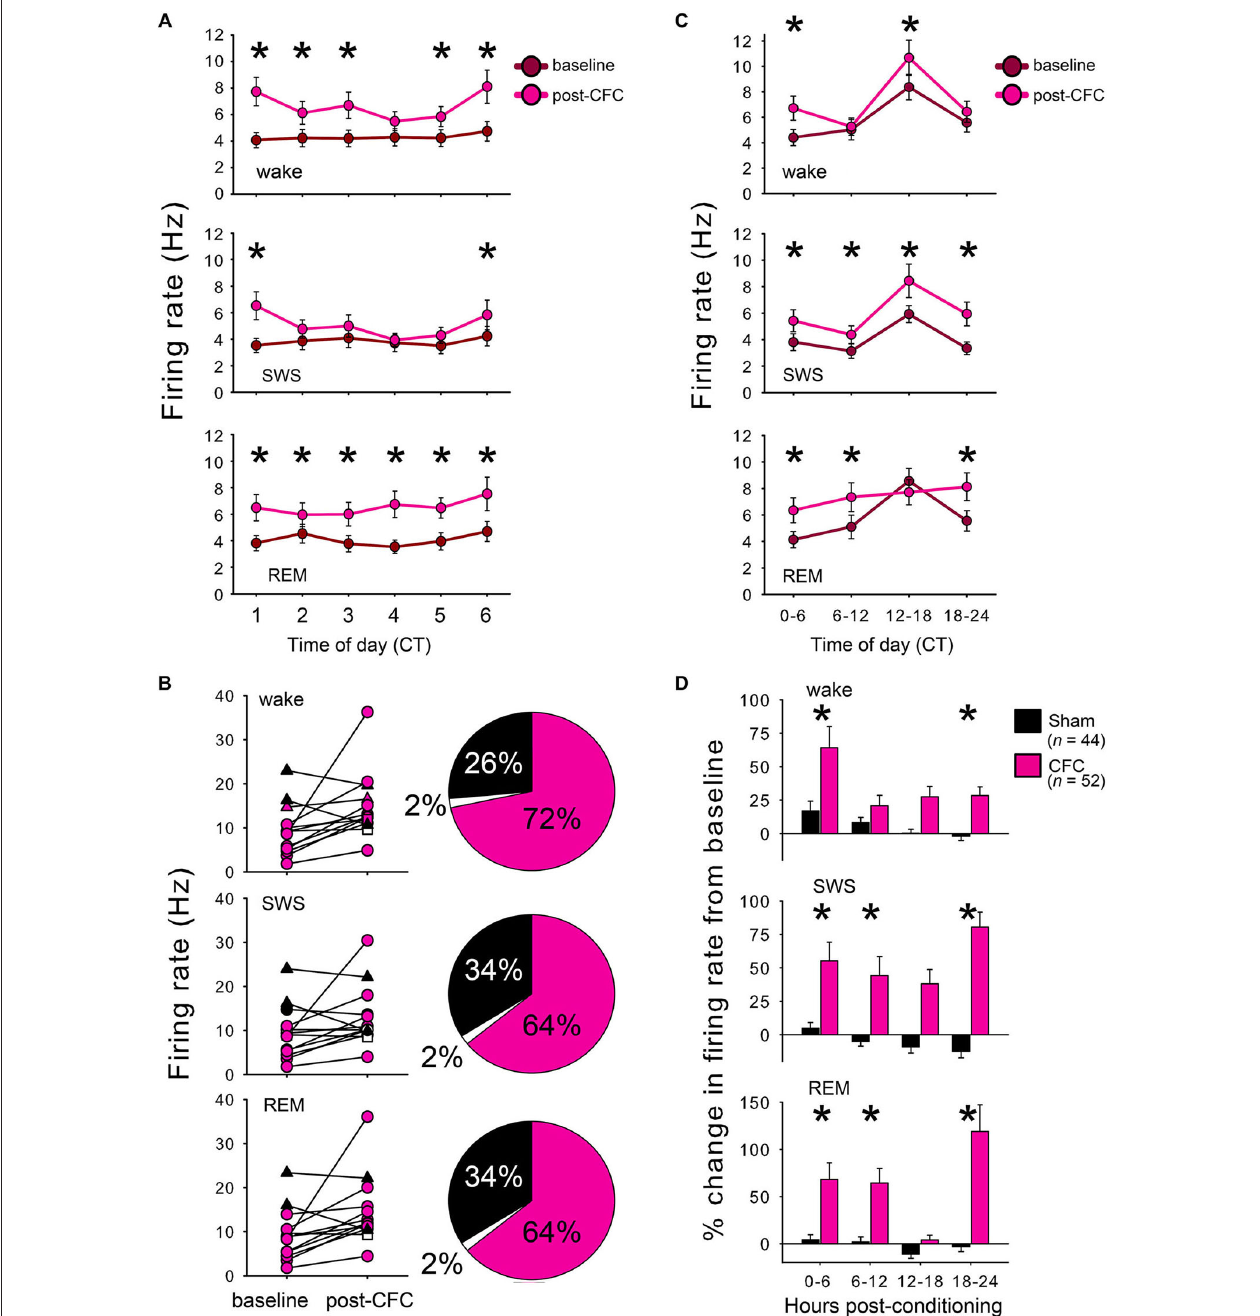
FIGURE 3 | CFC induces long-lasting increases in CA1 neuronal firing rates. (A) Mean firing rates for CA1 neurons increased within the first hours following CFC. For all 3 states, main effect of conditioning p < 0.05; conditioning × time interaction p < 0.001 for wake and SWS, two-way RM ANOVA. (B) Firing rate changes in each state are shown for individual neurons within a single representative CFC mouse (left) and the proportion of neurons showing increases, decreases, or no change in firing after CFC are summarized across all experiments (right). Neurons with a > 5% increase in firing from baseline are shown in pink, those with > 5% decrease are shown in black, and those with no change are shown in white.